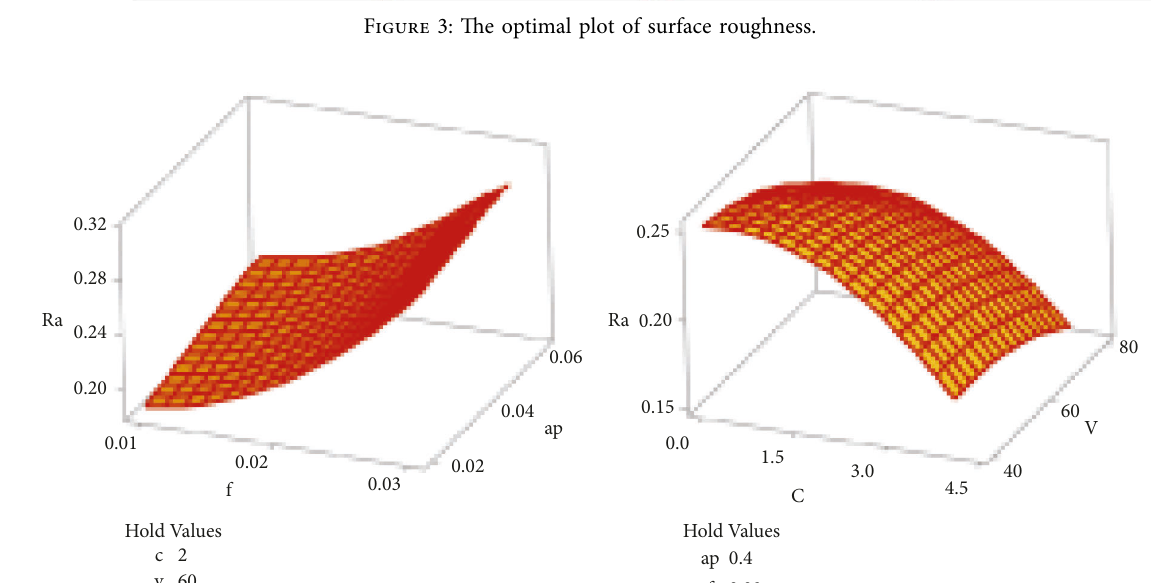
Figure 4: Surface plot of